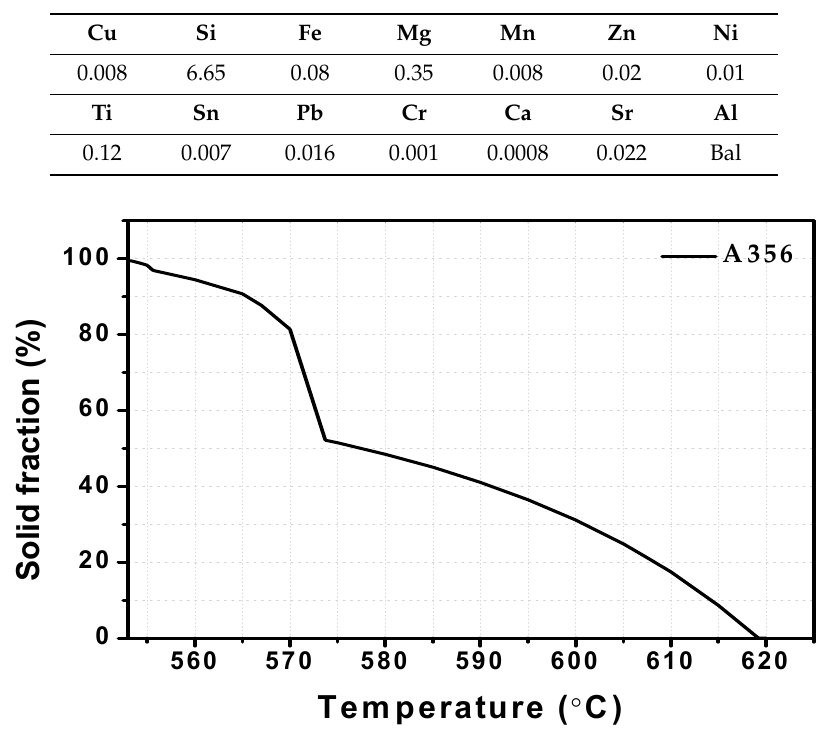
Figure 3. Change in solid fraction with temperature of A356.